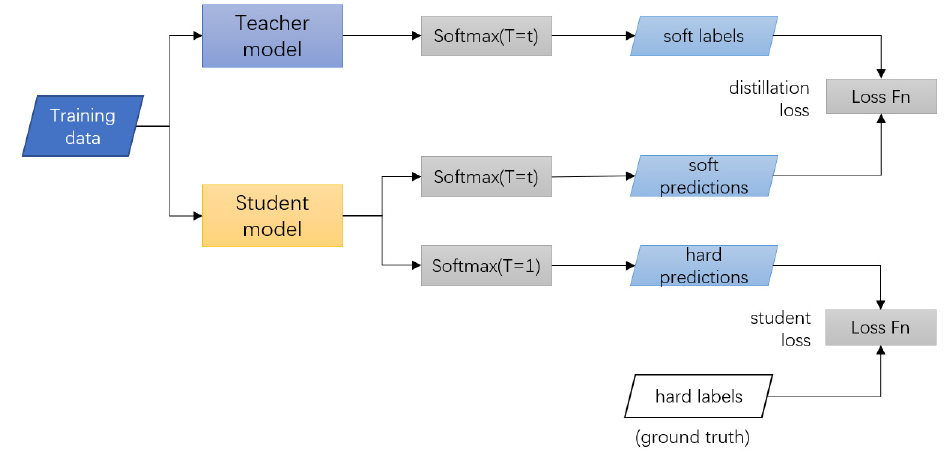
Figure 2. Process of knowledge distillation algorithm.